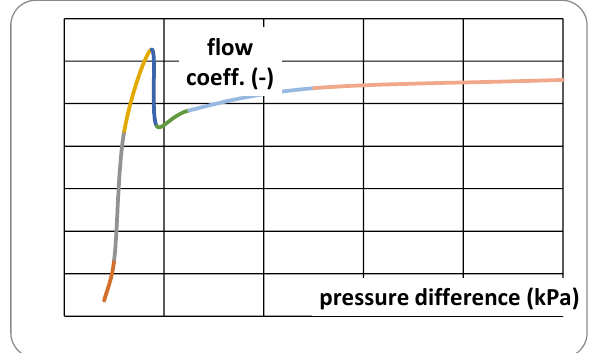
Fig. 3-11. Flow coefficient for the case from Fig. 3-10.